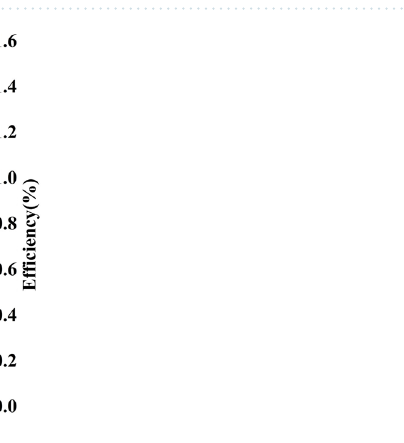
Figure 10. The simulated and measured E-plane radiation patterns.